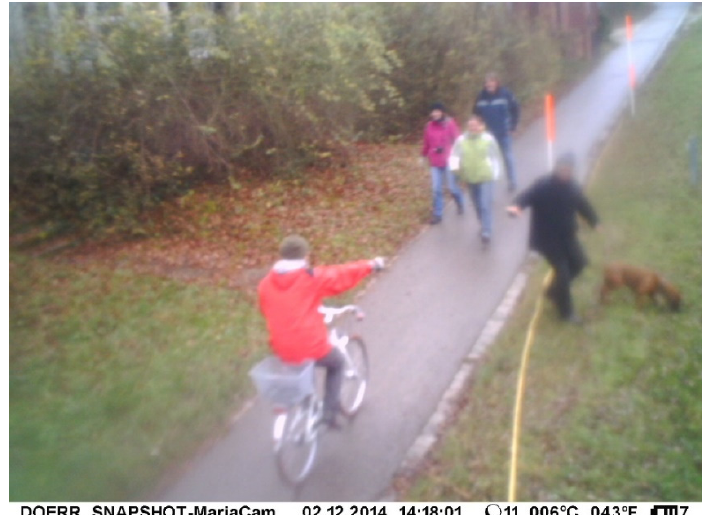
Figure 4. Picture taken by camera trap during the testing at the Freising University campus in late 2014, Bavaria, Germany.